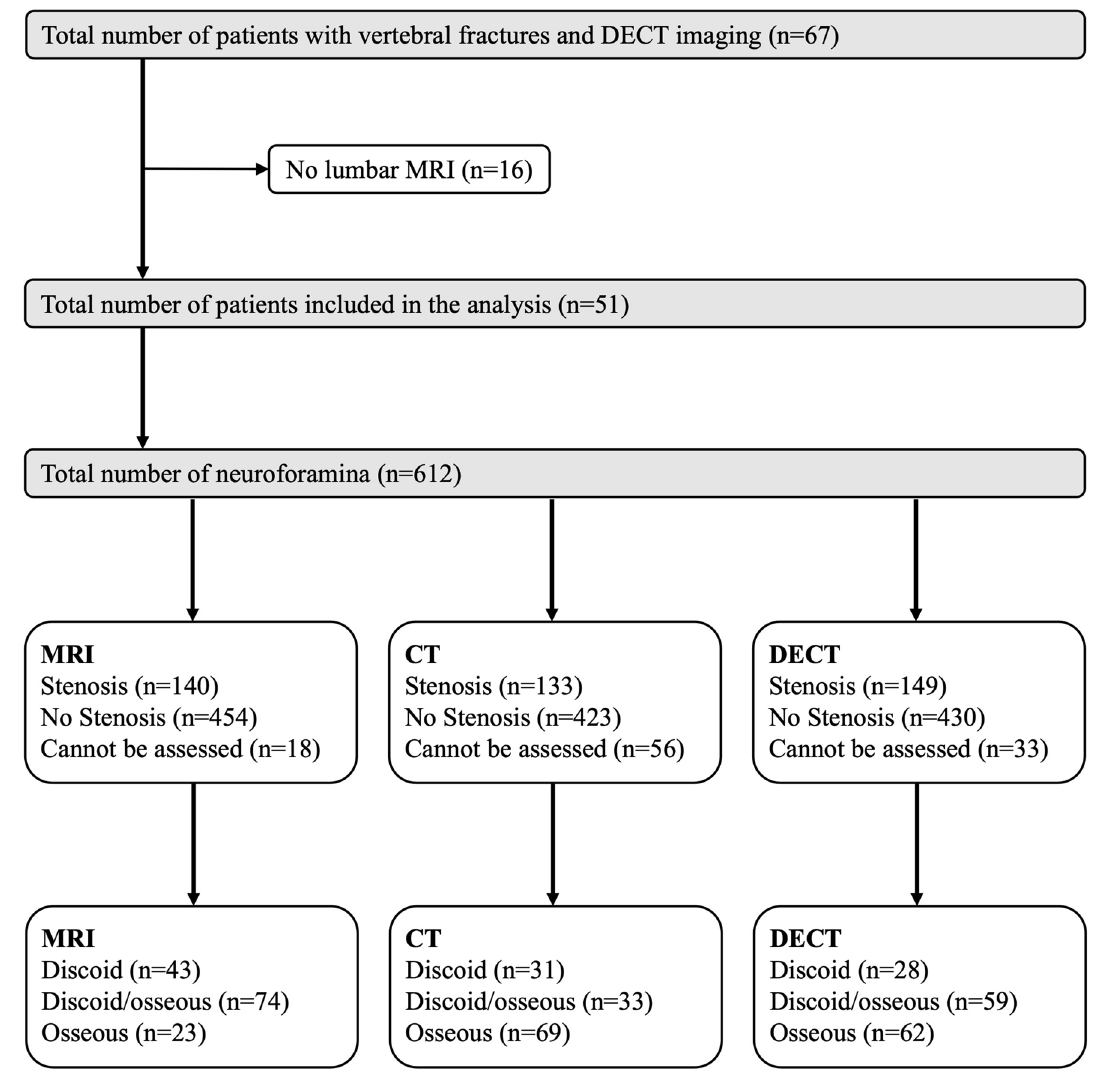
Figure 2. Patient flow chart. All patients who underwent DECT imaging were included while patients with missing lumbar MRI were